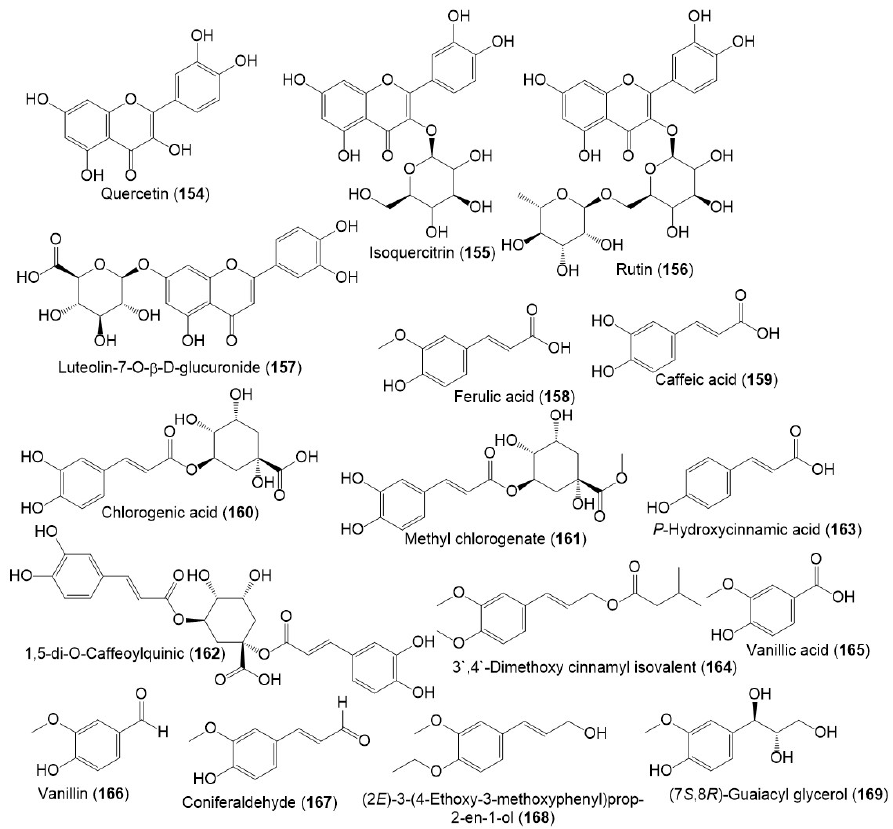
Figure 18. Structures of phenolic compounds ( 154 – 169 ) reported from F. sinkiangensis . From the resin extract, new tetrahydrobenzofuran derivatives: sinkiangensis A–C ( 182 – 184 ) were purified using SiO 2 CC/HPLC and elucidated by spectral and ECD analyses (Figure 20) [46]. Besides, sinkiangenrin C ( 192 ), a new organic acid glycoside was purified from seeds 95%EtOH extract. It is a 2-(1-hydroxyethyl)-4-methyl pentanoic acid 4-O- β -D- glucopyranoside